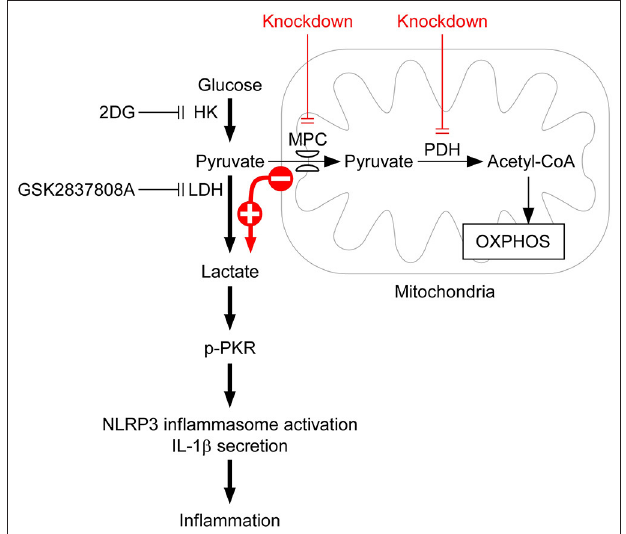
FIGURE 6 | Model for lactic acid fermentation-dependent activation of the NLRP3 inflammasome. Upon stimulation with NLRP3 inflammasome agonist, HK-dependent glycolysis is activated and contributes to NLRP3 inflammasome activation. Based on the results obtained in this study, we propose that lactic acid fermentation following glycolytic flux is required for NLRP3 inflammasome activation, whereas pyruvate oxidation is not. By contrast, downregulation of lactic acid fermentation by 2DG or GSK2837808A inhibits lactate-dependent phosphorylation of PKR and consequently prevents NLRP3 inflammasome activation, IL-1 β secretion, and inflammation. Although pyruvate oxidation converts pyruvate into acetyl-CoA, which is important for fueling respiration, inhibition of pyruvate oxidation by depletion of either MPC or PDH reprograms pyruvate metabolism from mitochondrial pyruvate-driven respiration to cytoplasmic lactic acid fermentation, and subsequently enhances activation of the NLRP3